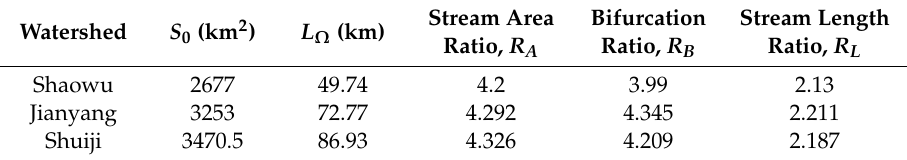
Table 1. The Horton geomorphologic indices and basic topographic values in Shaowu, Jianyang, and Shuiji